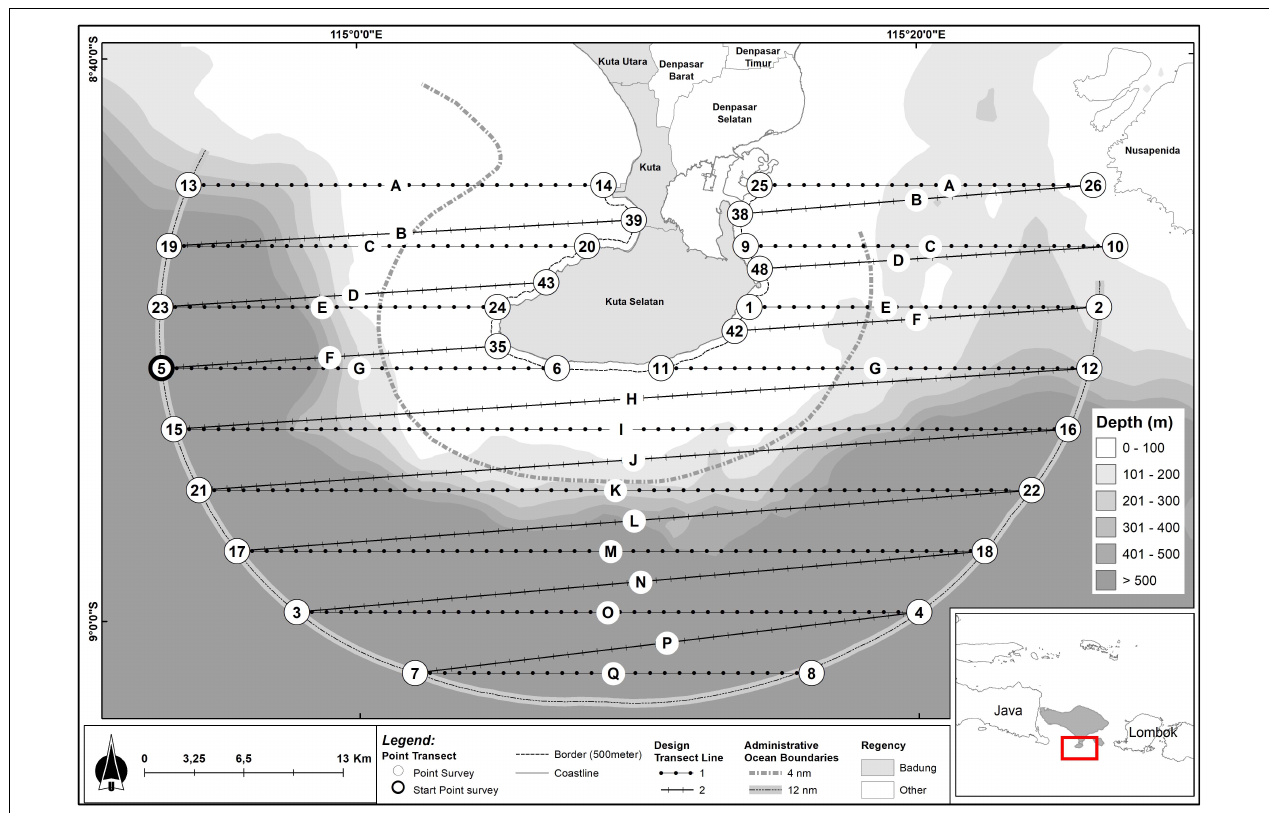
FIGURE 1 | Original design for the line transect survey of Bukit Peninsula, southern